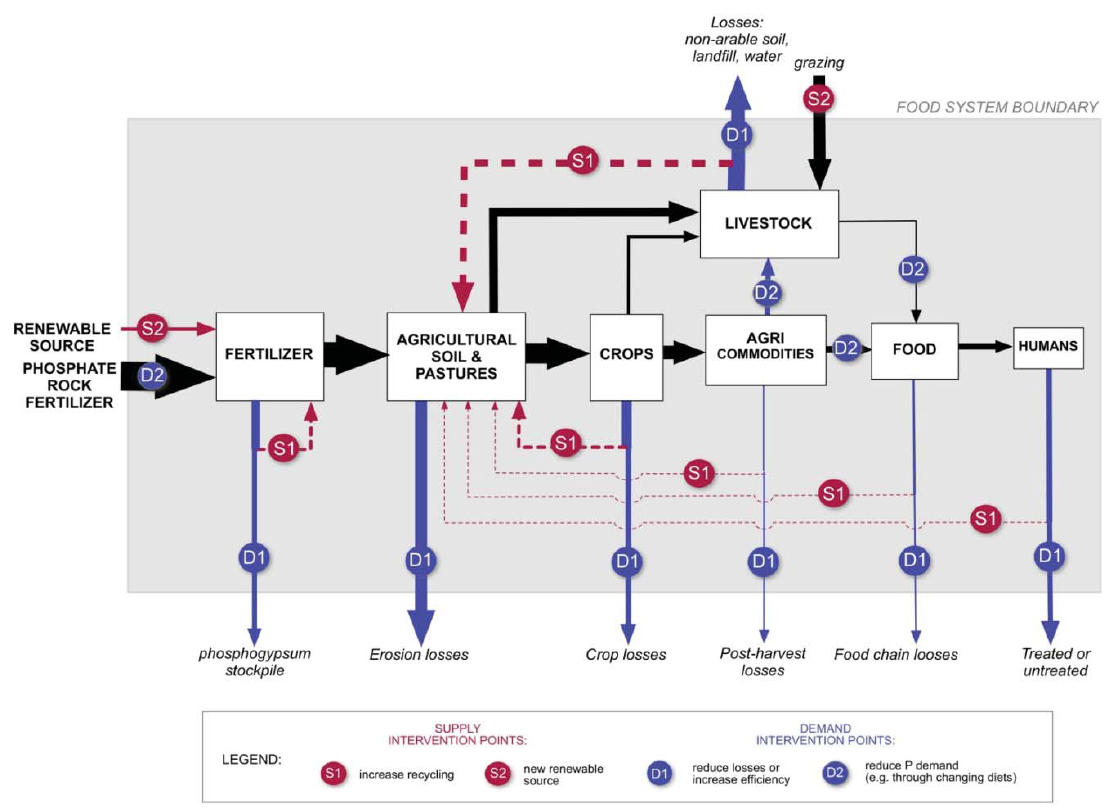
Figure 2. Sustainable phosphorus measures indicated as intervention points in the food system. These are classified as either supply measures—increasing recycling (S1) and new renewable sources (S2); or demand measures reducing avoidable losses or increasing efficiency (D1) and reducing phosphorus demand through changing diets (D2). Adapted from Cordell et al.